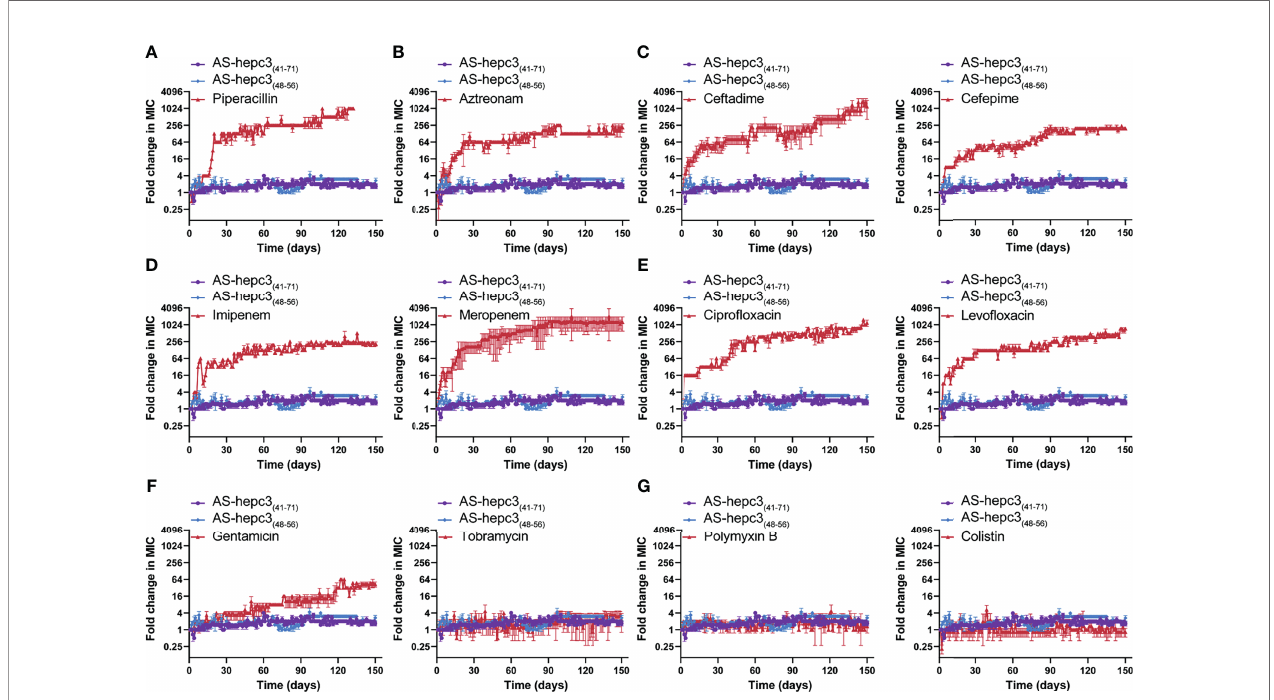
FIGURE 5 | AS-hepc3 (47-71) and AS-hepc3 (48-56) kill P. aeruginosa PAO1 without inducing resistance selection after serial passaging treatment in the presence of sub-MIC. Antibiotics for comparisons, (A) Piperacillin; (B) Aztreonam; (C) Ceftazidime and Cefepime; (D) Imipenem and Meropenem; (E) Cipro fl oxacin and Levo fl oxacin; (F) Gentamicin and Tobramycin; (G) Polymyxin B and Colistin. The y-axis indicates the fold change (in log 2 ) of the minimal inhibitory concentration (MIC) relative to the MIC of the fi rst day during passaging, and the x-axis represents the number of days. The experiment is performed in triplicate.